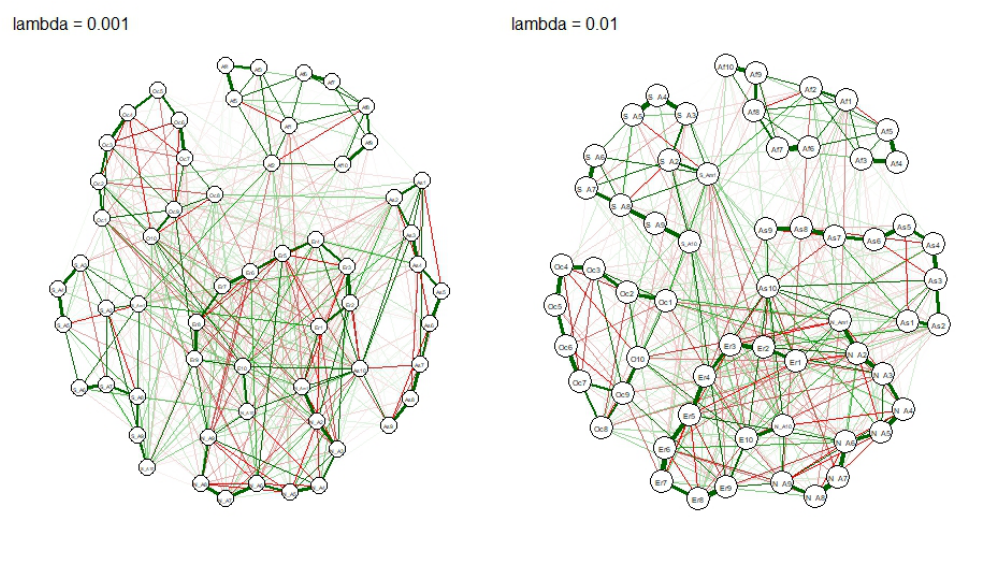
Figure 4. GLASSO partial correlation networks [varying lambda],